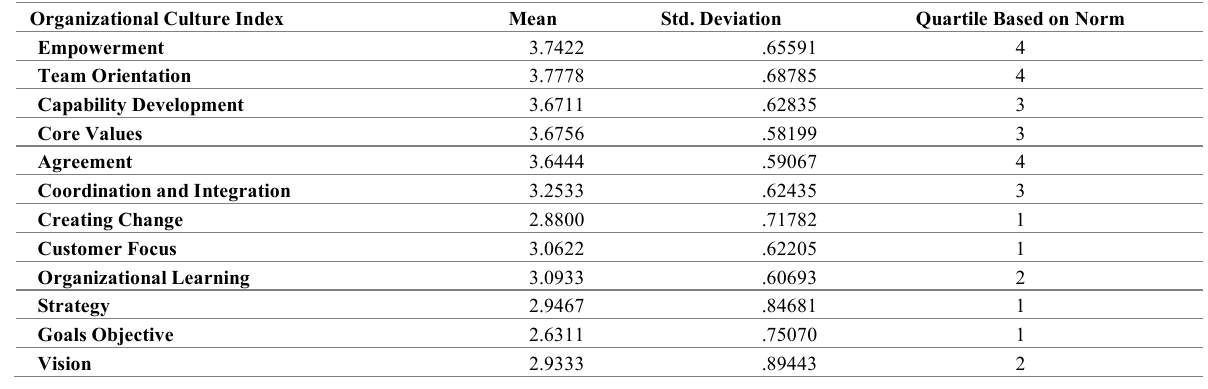
Table 1: Descriptive Statistics of Organizational Culture Index